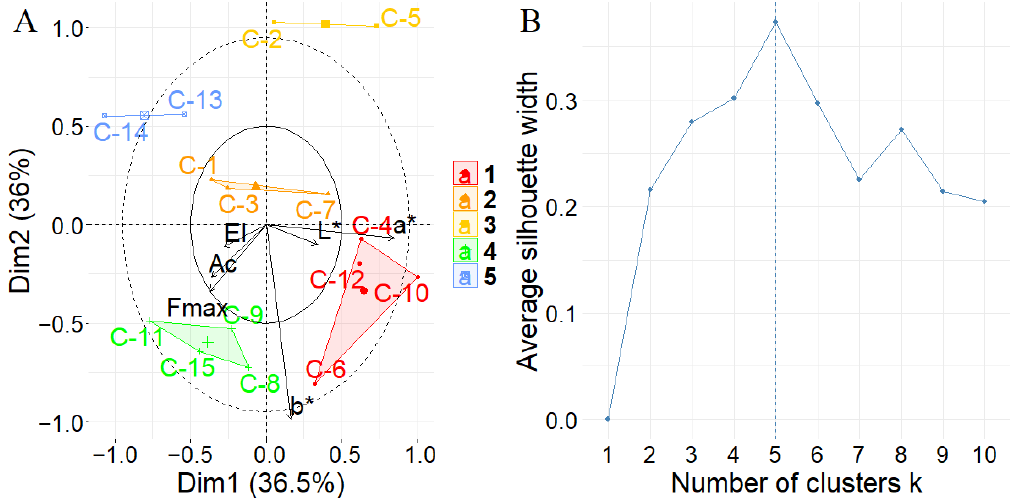
Figure 7. Results of the clustering analysis on LMM-ASCA decomposition of the “Dairy Factory” factor; ( A ) representation on clusters; ( B ) results of the Elbow method for the estimation of the optimal number of clusters. Score values for each level are represented by black dots, and labeled from C-1 to C-15 for each dairy factory, and colored according to the cluster estimated. Loading values are represented using arrows for each parameter acquired: “El” stands for elastic modulus; “Ac” for area under the curve; “Fmax” for maximum force; “L*”, “a*”, and “b*” labels are referred to the coordinates of the lab color spaces.